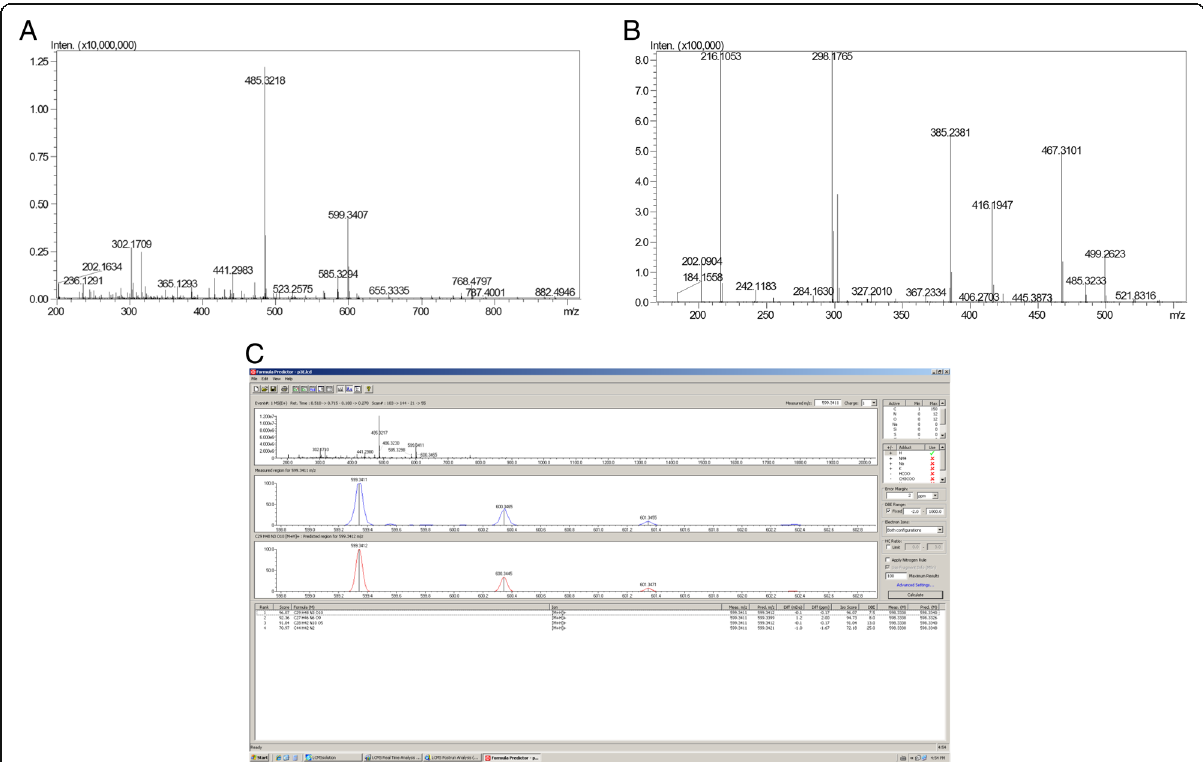
Fig. 4 Mass spectrometry analysis of p3E and its characterization. a MS profile. b Fragmentation of 599 m/z ion. c Software analysis for prediction of molecular